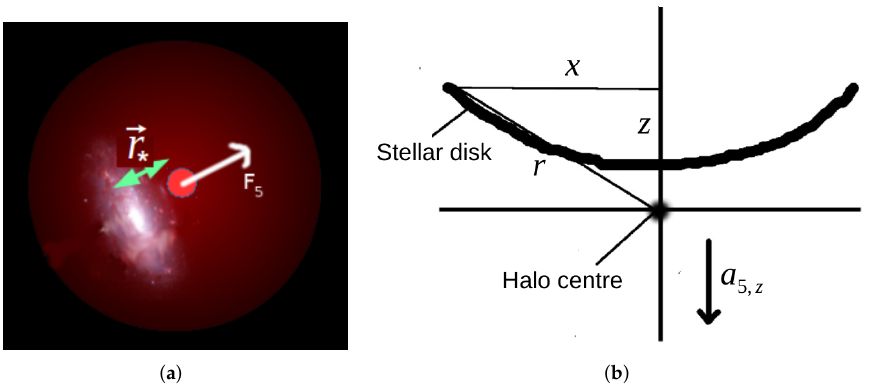
Figure 6. Cartoons illustrating ( a ) separation of stars and gas in galaxies under a fifth force, and ( b ) the warping of stellar disks. ( b ) is reproduced from